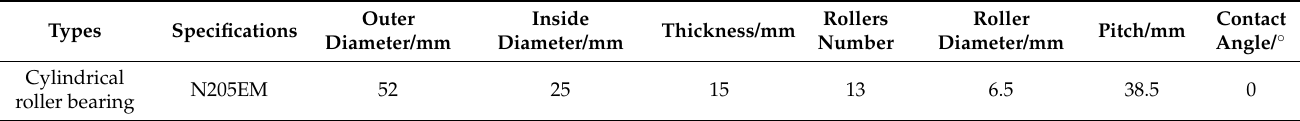
Table 4. Specifications and parameters of test bearings.